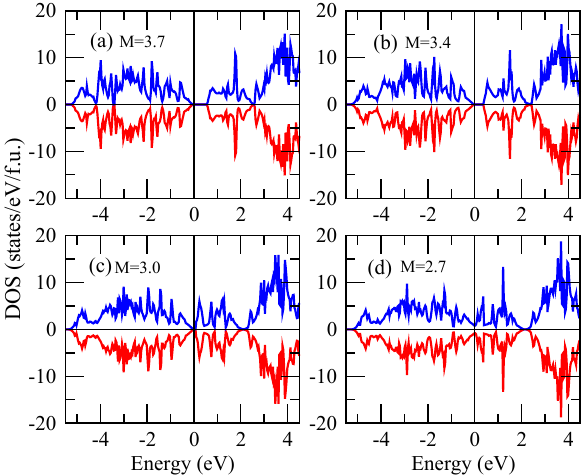
Figure 6. Calculated density of states of ThMnPN with the C-AFM spin configuration for fixed Mn moments with an effective Hubbard U of 0.9 eV ( a ) M = 3.7 µ B , ( b ) M = 3.4 µ B , ( c ) M = 3.0 µ B , and ( d ) M = 2.7 µ B . Up-spin and down-spin density of states are indicated by blue and red lines, respectively. The Fermi level is denoted by a vertical black line at E = 0